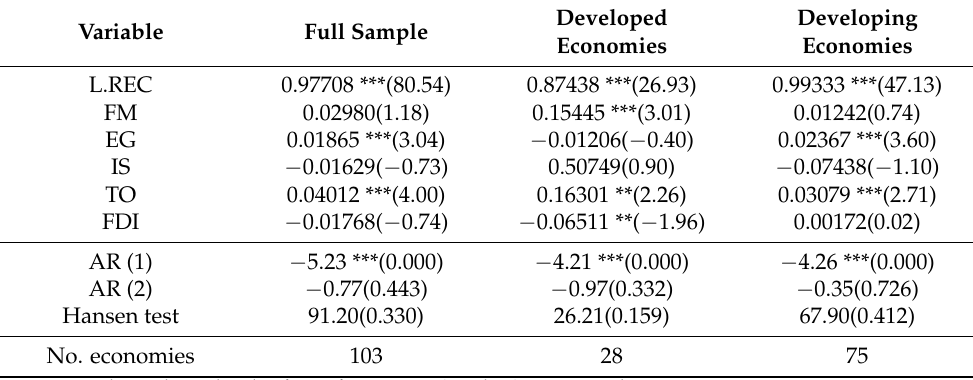
Table 8. Regression results of second level of financial development